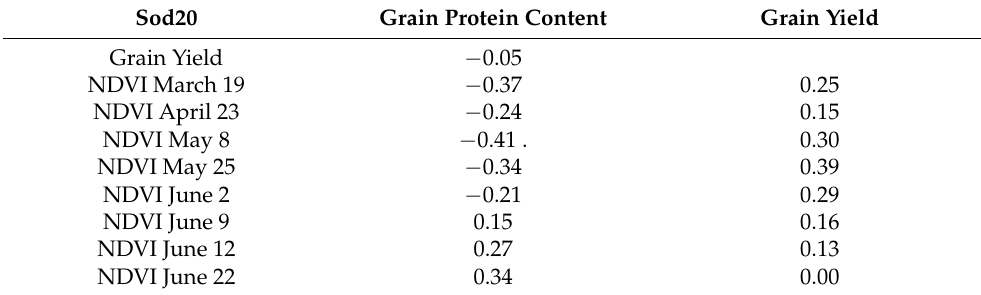
Table 11. Pearson correlation analysis and significance levels between NDVI, grain yield, and protein content for the Sod20 field (. =